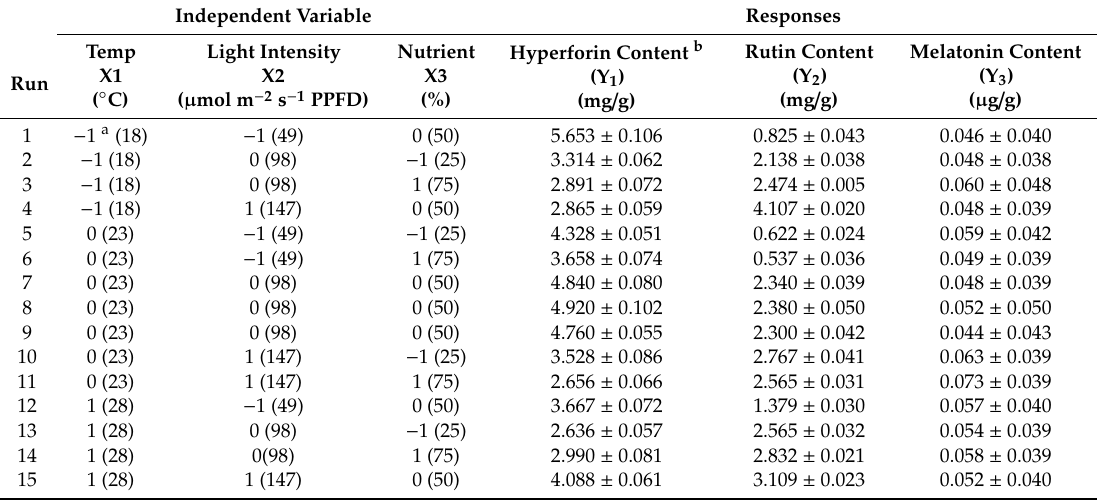
Table 1. Box-Behnken design in coded and actual levels of variables and the response